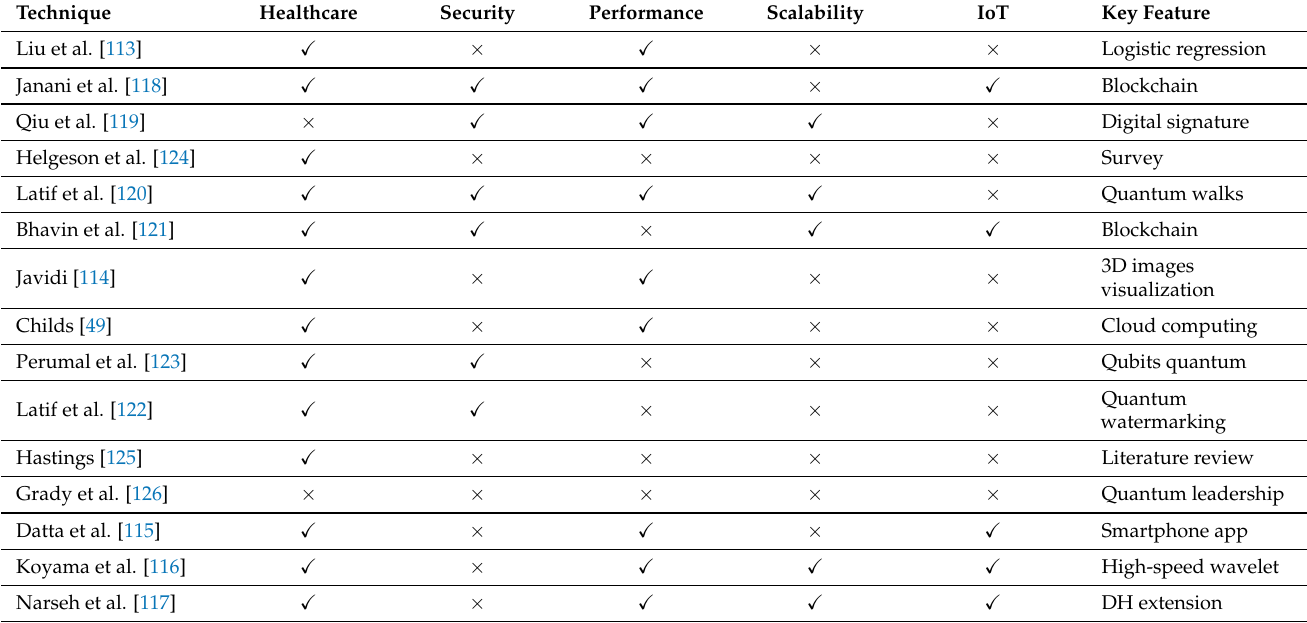
Table 4. A comparison of the existing quantum computing literature on healthcare using different performance parameters.